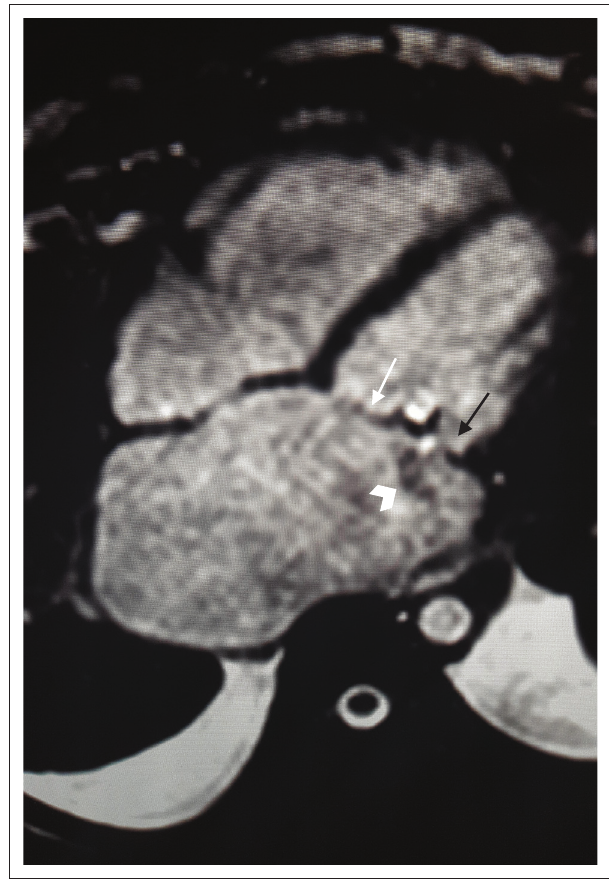
FIGURE 9: SSFP four-chamber view demonstrates prolapse of the anterior leaflet (white arrow) in relation to the posterior leaflet (black arrow) and a posterolateral directed regurgitation jet (arrowhead).